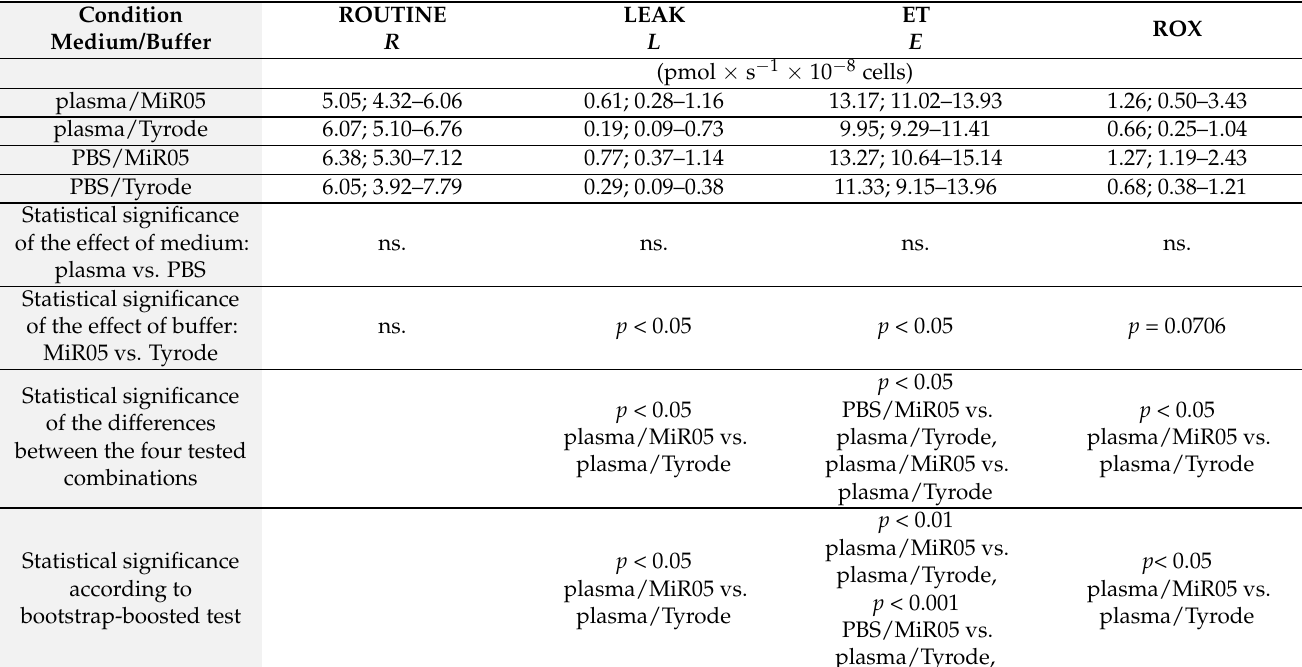
Table 3. Mitochondrial respiration parameters measured for platelets resuspended in four different medium/buffer